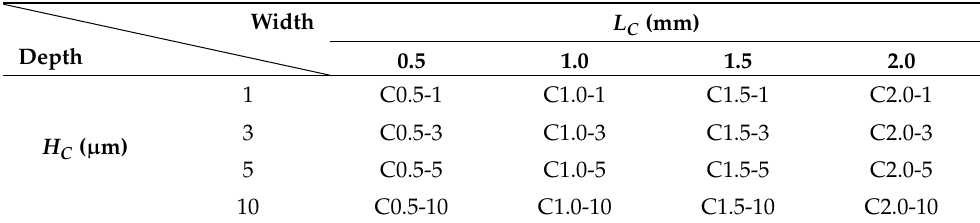
Table 2. Different micro-chamfering widths and depths